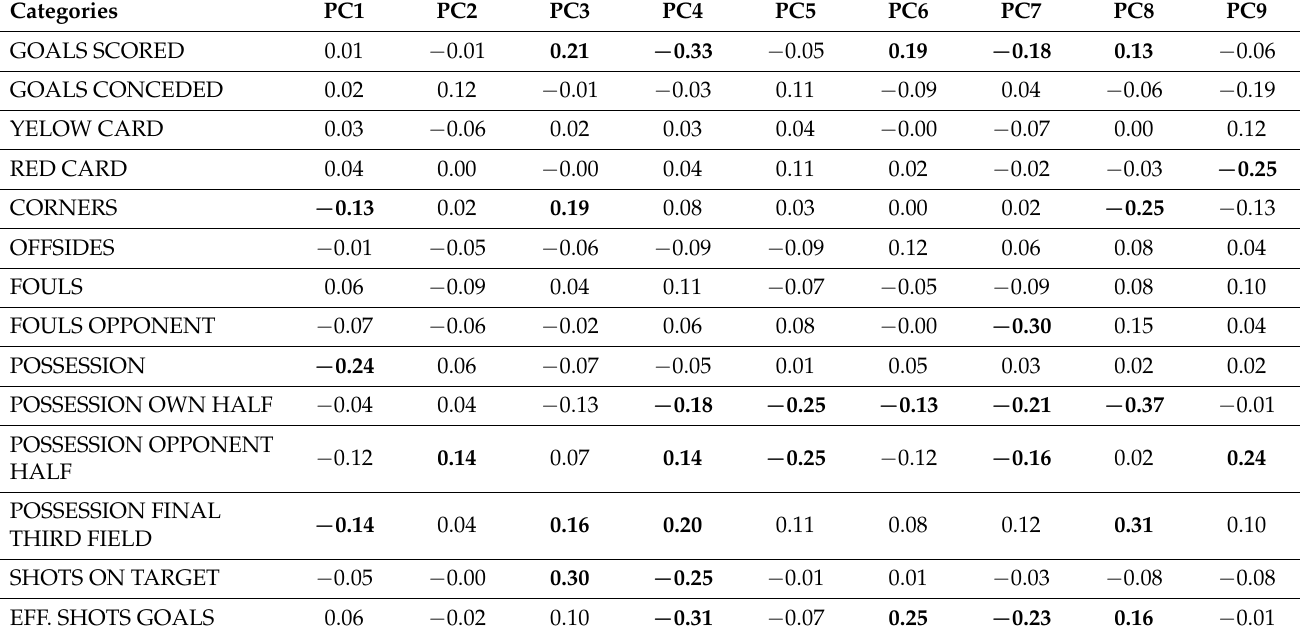
Table 5. PCA factorial matrix of bottom